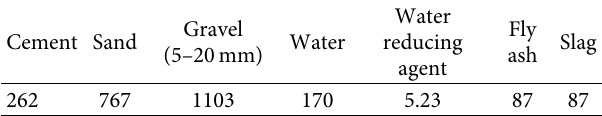
Table 7: Mix proportion for concrete specimens (grade C30). Unit: kg/m 3